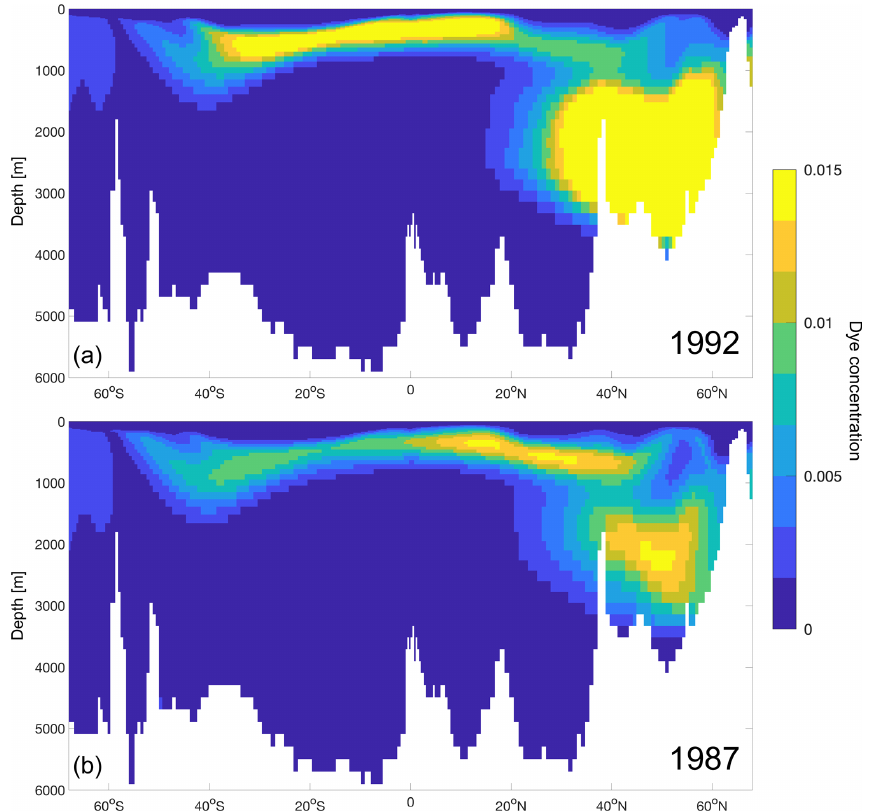
Figure 12. Tracer concentration 25 years after injection for two of the vintages: one that was injected in a year of strong Northern Hemisphere convection (a) and one that was injected in a year of weak Northern Hemisphere convection (b) , along a mid-Atlantic north–south section (as shown in the inset of Fig. 5a).